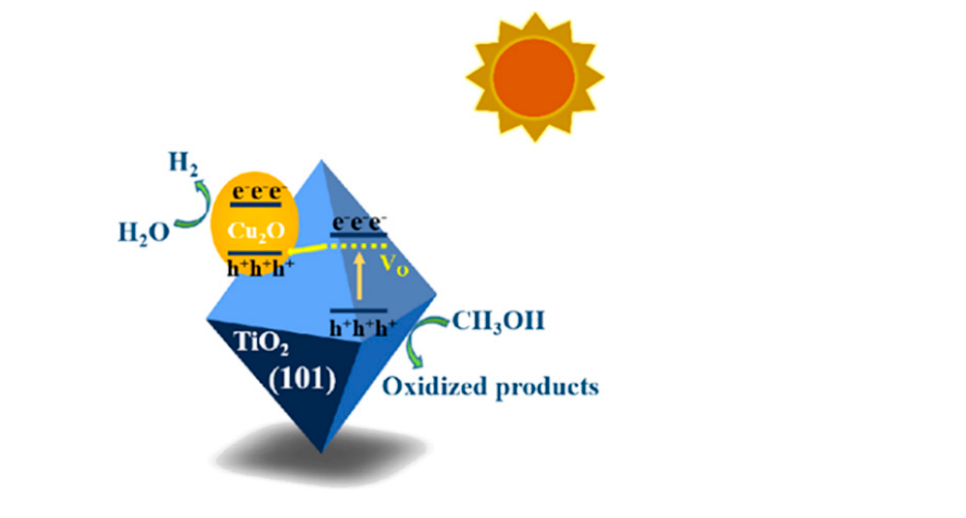
Figure 15. Schematic diagram of Z-schemed catalyst of Wei et al. [57] Reprinted with permission from ref. [57].